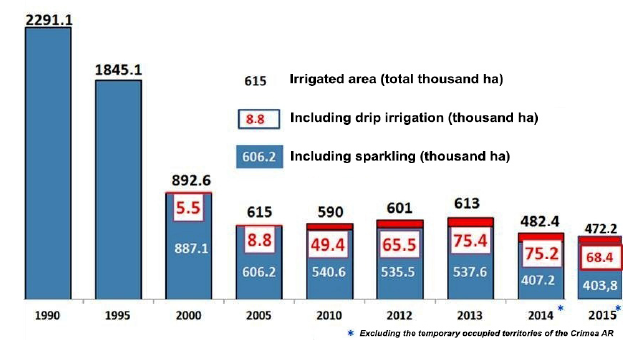
Figure 4. Total water abstraction from natural water bodies for the production of electricity, millionm 3